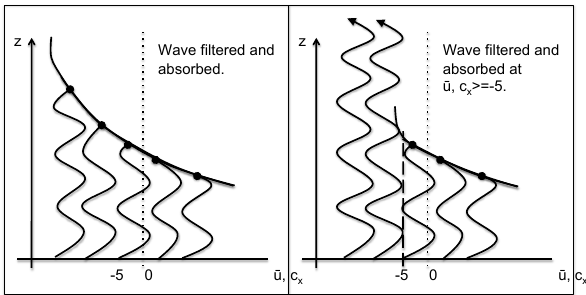
Fig. 9. A schematic diagram of the mechanism proposed by Garcia and Sassi (1999) for the filtering of gravity wave by the westward winds of the MSAO. The upward oscillations show wave propagating in the atmosphere, were the circle ended waves are filter and absorbed by the background flow and the arrow ended wave propagate into the atmosphere. The dashed line at -5 shows the critical wave velocity. wave propagation. The right-hand panel shows the waves being allowed to propagate upwards freely. Free upward propagation can occur when the background flow is less than the critical phase speed. Thus the gravity-waves can reach the mesosphere and wave modulate the MSAO. This was observed here during February to April of 2002 and in 1993 and 1995 by Garcia et al. (1997).